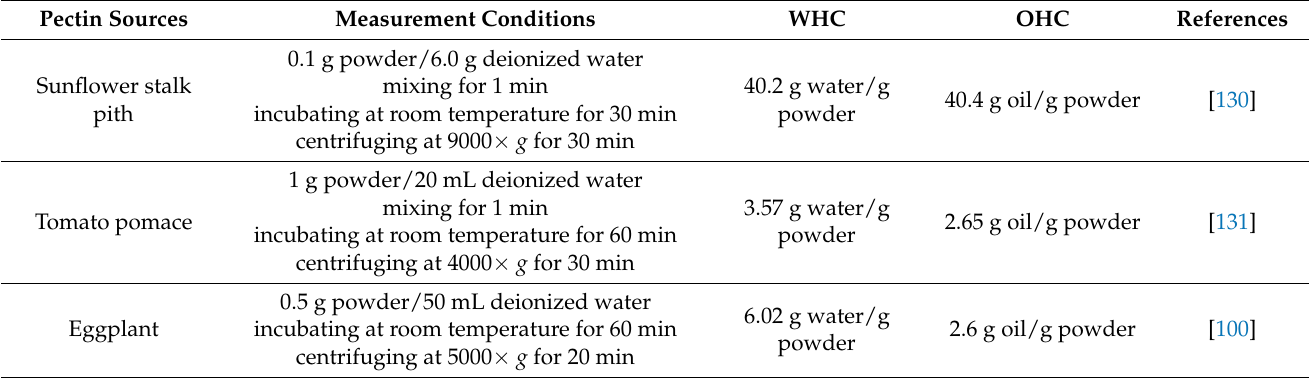
Table 3. Water-holding capacity (WHC) and oil-holding capacity (OHC) of pectin extracted from various sources. Pectin